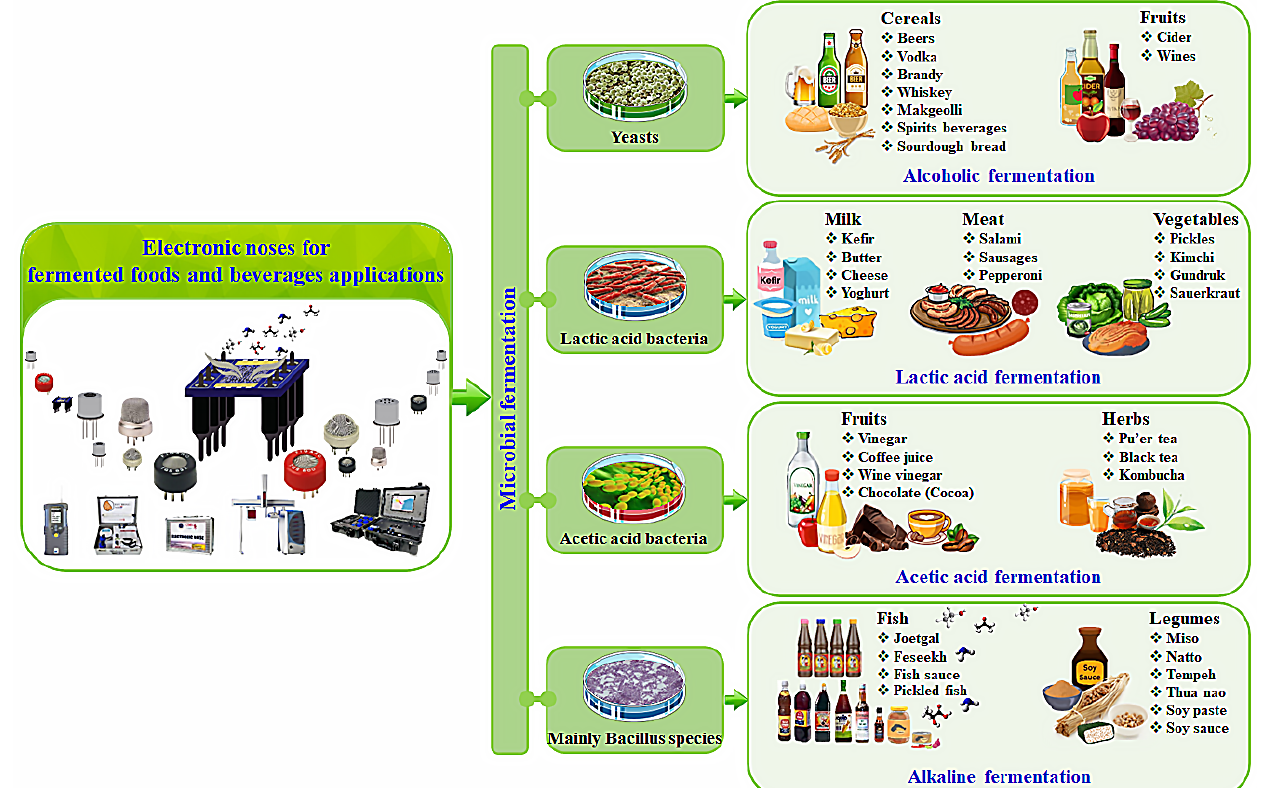
Figure 1. Applications of E-nose for fermented food and beverage.